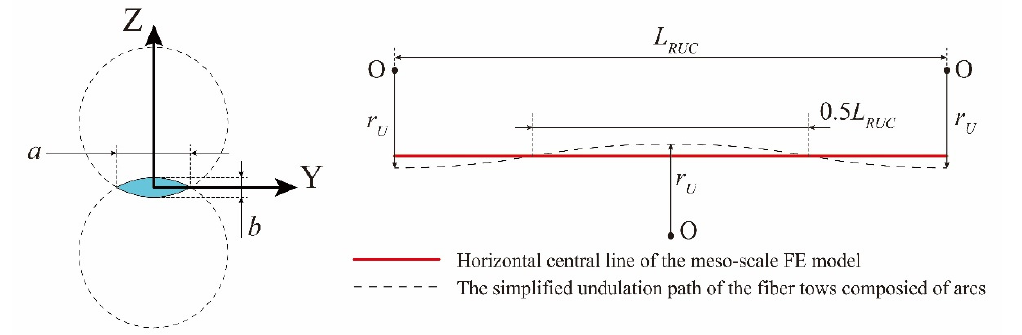
Figure 16. Meso-scale FE model of the utilized T300/Epoxy PWF composite.